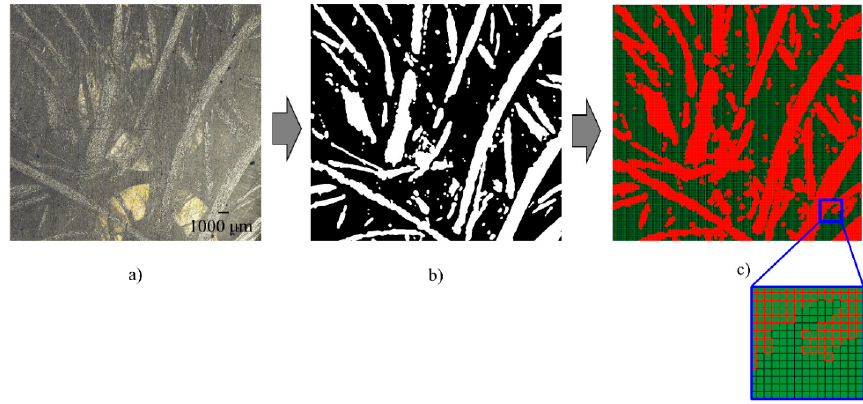
Figure 6. Image of representative microstructure and process analysis to assign a conforming mesh; ( a ) Original image collected through optical microscopy with a magnification of 100 × showing the carbon fiber distribution from mixing Method 1, ( b ) Processed image after transferring to black and white and application of color threshold and blur and contrast filters the areal fiber fraction is ~33%, and ( c ) Conforming mesh to the microstructure based on color separation.